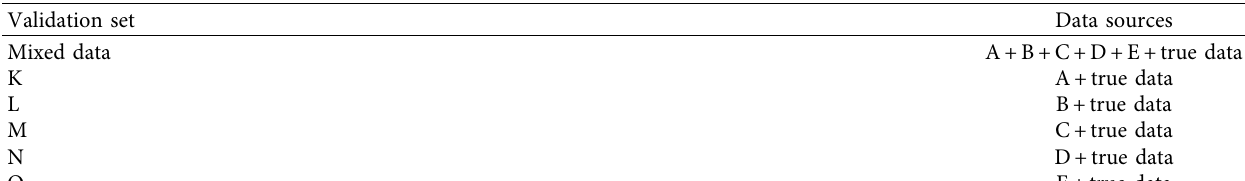
Table 5: Data composition for experimental verification.